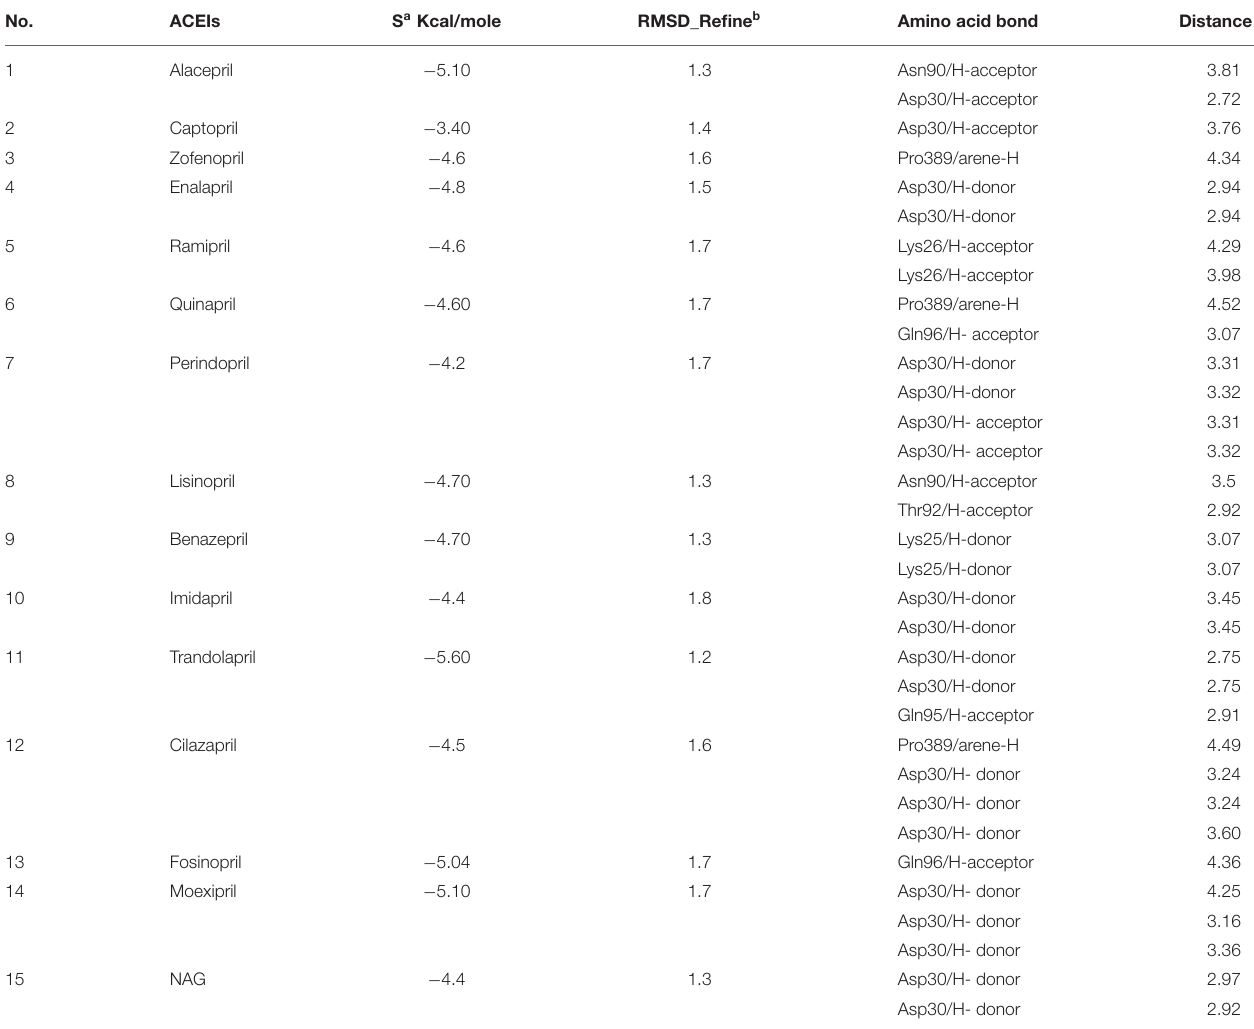
TABLE 1 | Receptor interactions and binding energies of ACEIs drugs and NAG inhibitor into the spike protein of SARS-CoV-2.